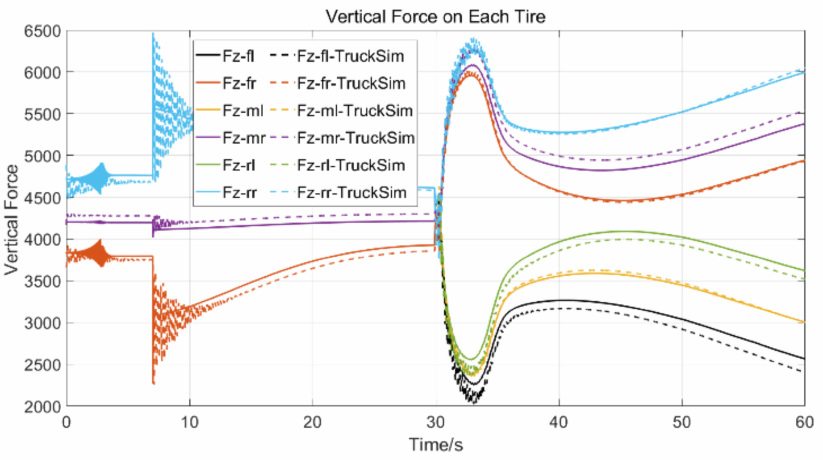
Figure 4. The vertical force estimation as compared with the TruckSim simulation